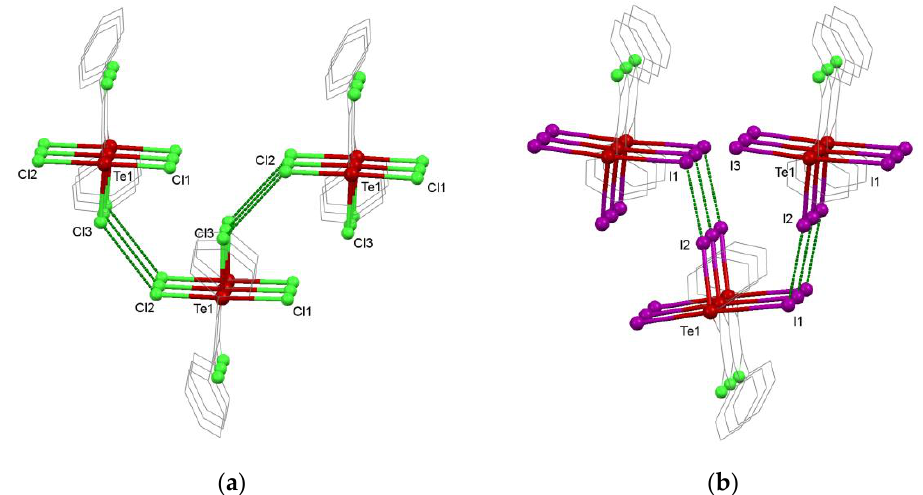
Figure 6. Comparison of the mutual arrangement of chains in 1 α and 2 α . Notice different Te-Cl · · · Cl and Te-I · · · I angles corresponding to type-I and type-II HaBs, respectively: ( a ) Selected intermolecular angles ( ◦ ): Te1-Cl2 · · · Cl3 127.94, Te1-Cl3 · · · Cl2 122.94; ( b ) Selected intermolecular angles ( ◦